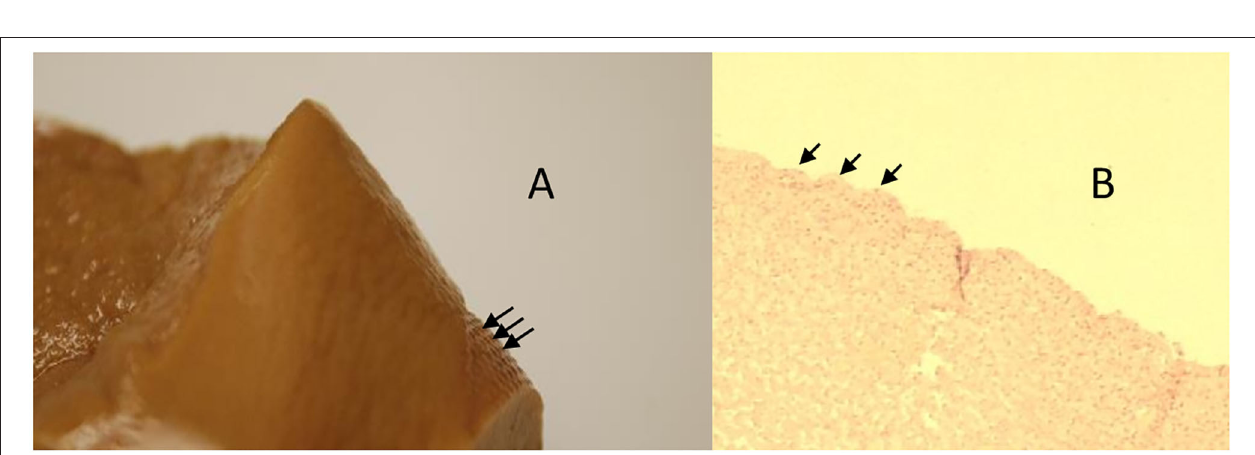
FIGURE 12 | Animal 1, − 80 mmHg. (A) Partial liver resection. Arrows mark areas with a paving stone surface, corresponding to the patched area. (B) Liver cut from the “patch” section. Superficially with a lobular shape (arrow) consisting of capsule and underlying, not pathologically altered liver cells.